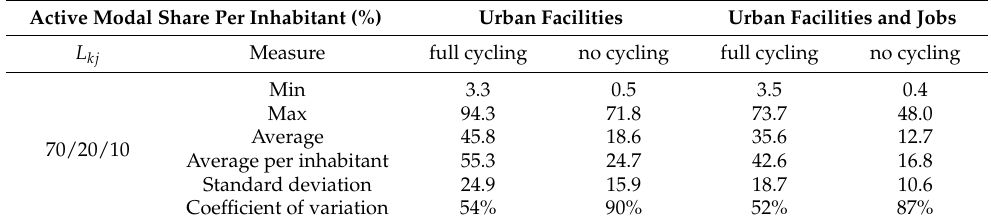
Table 3. Active modal share summarizing statistics.